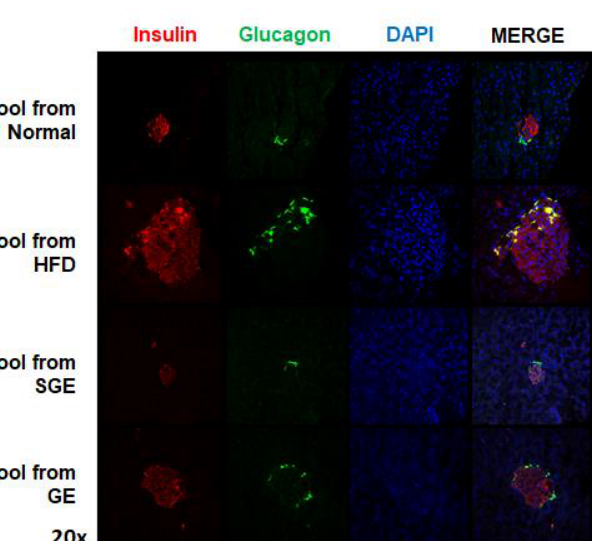
Figure 4. The stools from mice having Korean red ginseng extracts prevent HFD-induced obesity and diabetes. ( A ) Experimental course. Mice ( n = 15/group) were fed ad libitum with normal or high-fat diet for 70 days. The stools from mice having the indicatives were per os added two times a week for 4 weeks. Stool samples were gathered for further research. ( B ) Gain of body weights. ( C ) Pancreatic cells expressing insulin and glucagon.